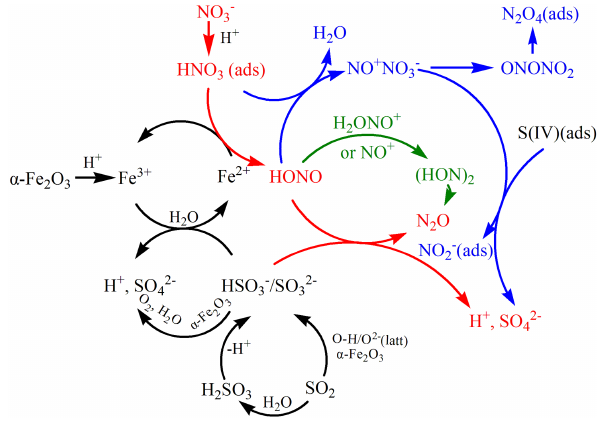
Figure 9. Schematic of the reaction mechanism of the heteroge- neous oxidation of SO 2 on hematite in the presence of